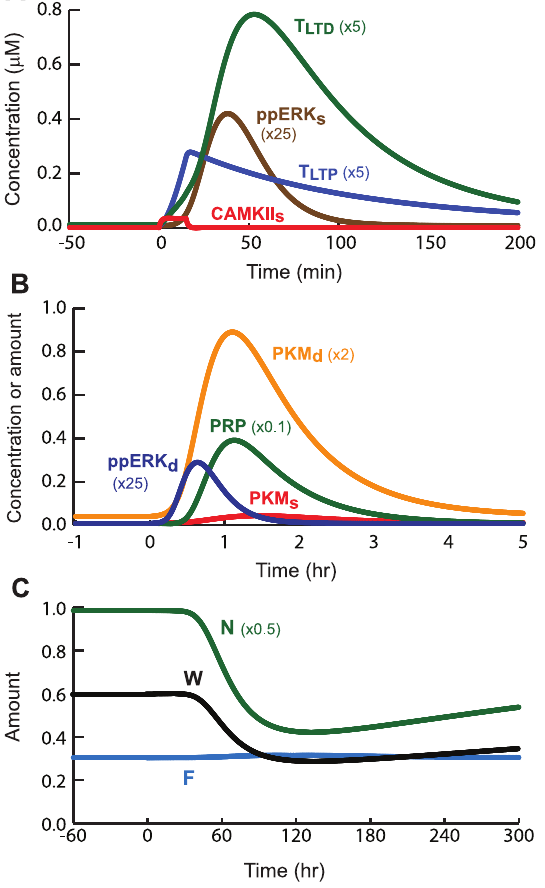
Figure 4. Simulated induction of LTD by the SLFS protocol. Time courses of ppERK s , T LTD , ppERK d , and PKM s are vertically scaled as indicated.